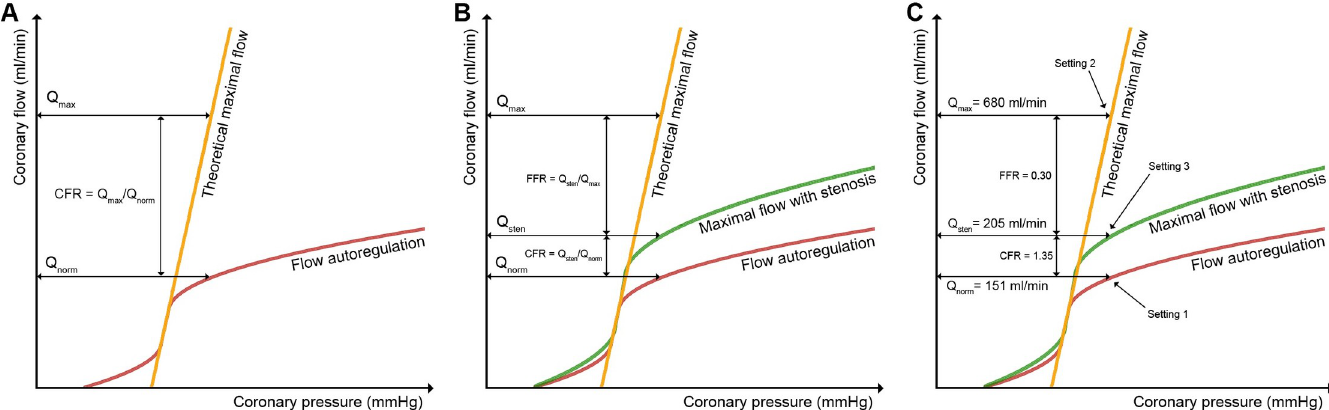
Fig 1. Schematic coronary flow/pressure diagrams. The diagrams visualize definitions of coronary flow reserve in the absence (A) or presence (B) of a haemodynamically relevant obstructing stenosis. In (C) , the experimental settings are denoted [7]. Setting 1 represents a healthy, non-dilatated vessel, in our case 4 mm inner diameter, e.g. right coronary artery, which is perfused with normal flow at rest (151 ml/min). Setting 2 represents an already dilated and hyperaemic perfused vessel (6 mm inner diameter) in the absence of a stenosis, simulating theoretical maximal flow of 680ml/min. Setting 3 represents the stenotic and therefore diseased vessel, perfused with hyperaemic flow and already dilated, resulting in a flow of 205 ml/min. In consequence, our simulated circulation phantom mimics a haemodynamic relevant stenosis with an FFR of only 0.30. In setting 4, the hyperaemic flow used in setting 3 is doubled to quantify very high flow in diseased vessels.